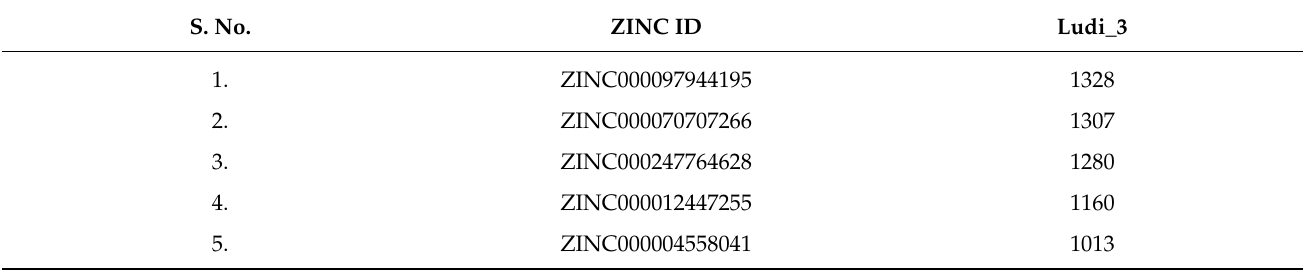
Table 2. LUDI scores for the virtually screened